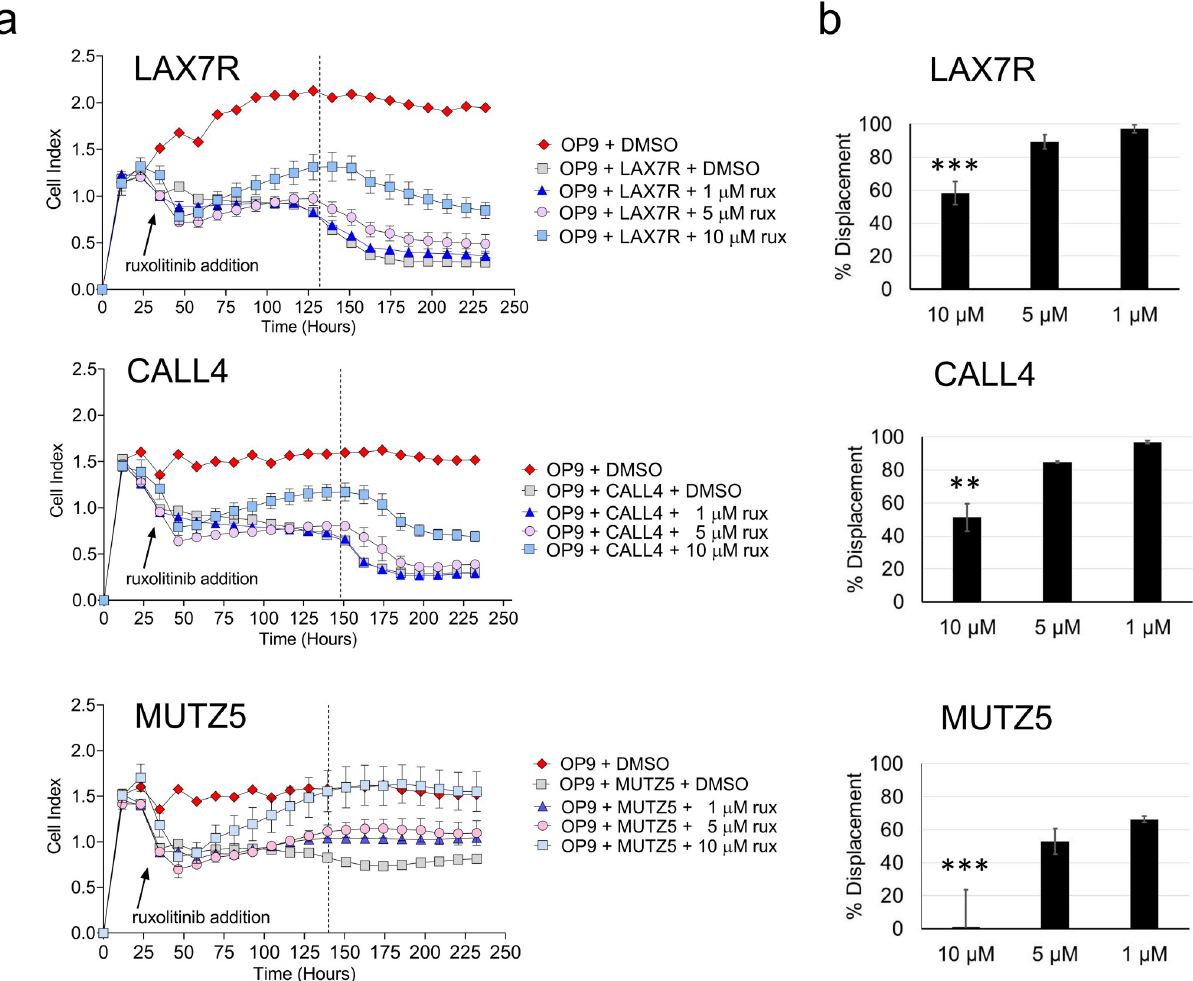
Fig 8. OP9 displacement can be utilized to test new drugs for BCP-ALL treatments. (A) Impedance profile of three BCP-ALL cell lines treated with the JAK2 inhibitor ruxolitinib (rux) (n = 3). Dotted lines show the time points used for the calculation of % displacement in panel B (also see S4 Fig) (B) Percentage impedance signal displacement from treatments with the indicated drug concentrations (n = 3). Statistical analysis was done using one-way ANOVA followed by Dunnett’s multiple comparison test to compare treatment samples versus the OP9+ALL+DMSO control wells. Error bars represent standard deviation. p values relative to control: � < 0.05; �� < 0.01; ��� < 0.001; ���� < 0.0001.